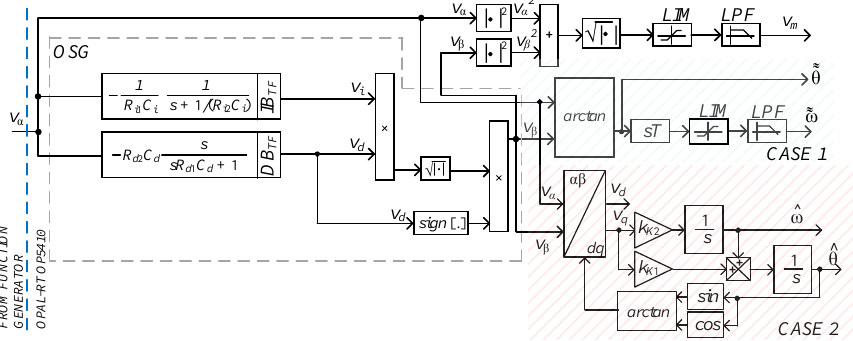
Figure 21. Complete system used for the validation of the proposed OSG and frequency / amplitude detection